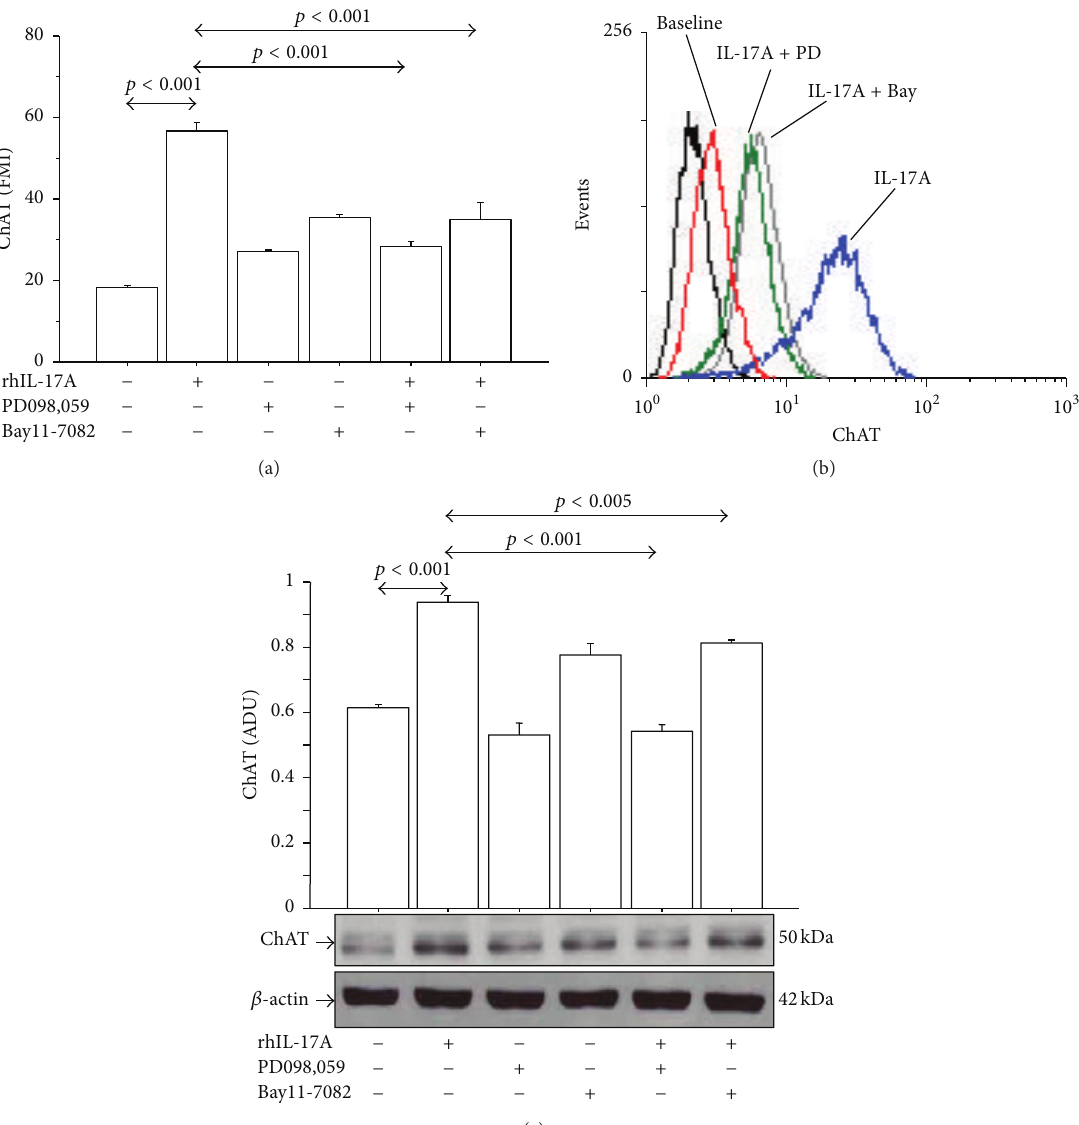
Figure 4: Effects of PD098,059 (25 𝜇 M) and Bay11-7082 (50 𝜇 M) on ChAT protein expression in 16-HBE cells. Cells were preincubated for 1h with PD098,059 (25 𝜇 M) or Bay11-7082 (50 𝜇 M) and then stimulated with rhIL-17A 20 ng/mL for 24 h to evaluate ChAT protein expression (a) by flow cytometry. Bars represent mean ± SD of fluorescence mean intensity (FMI) of three separate experiments. Representative (b) flow cytometry analysis and western blot (c) are shown. Bars represent mean ± SD of arbitrary densitometric units (ADU). Representative western blot is shown. Statistical analysis was performed by ANOVA test followed by Fisher’s PLSD multiple comparison test. The black curve represents the anti-IgG isotype negative control